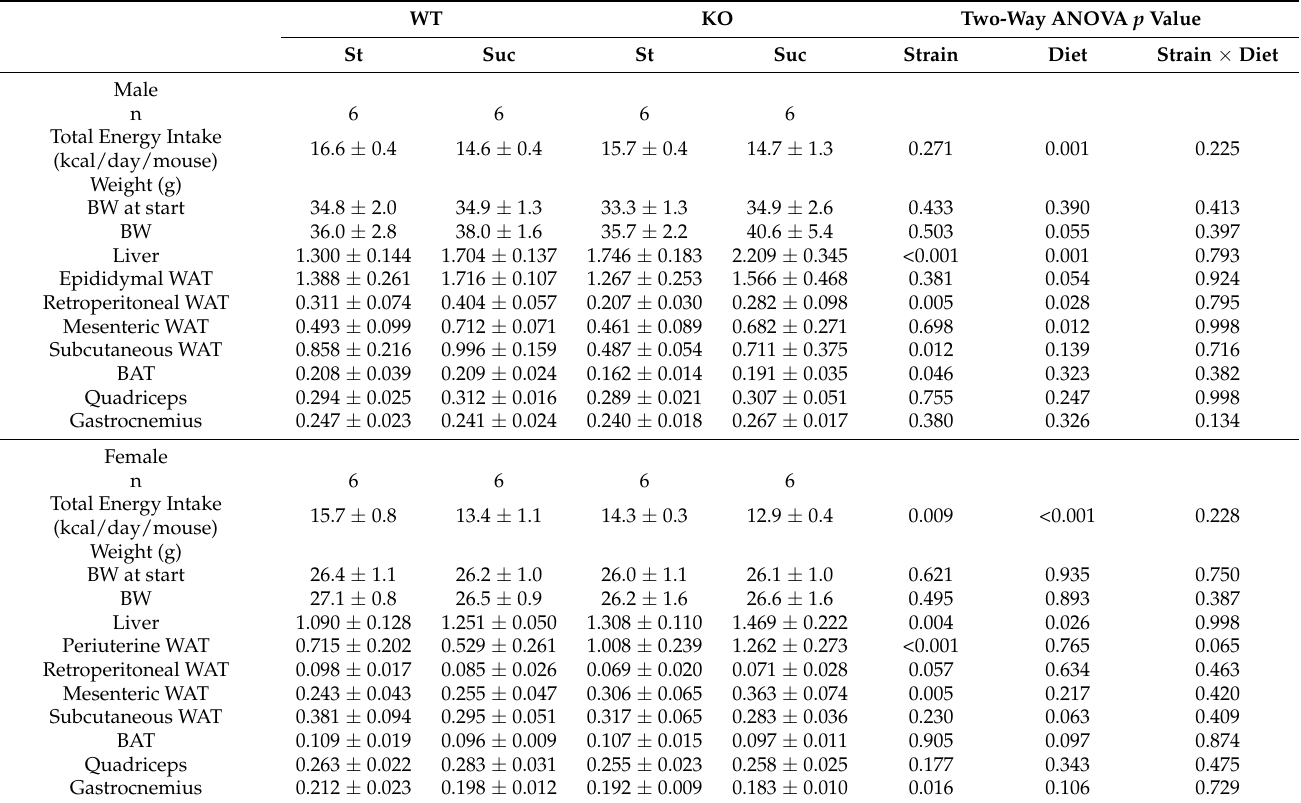
Table 3. Body and tissue weights and total energy intake.